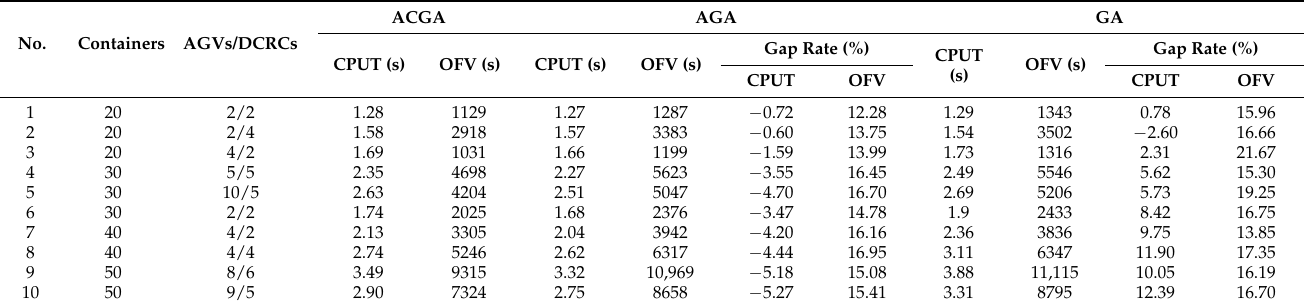
Table 2. Comparison table of small-scale problems.